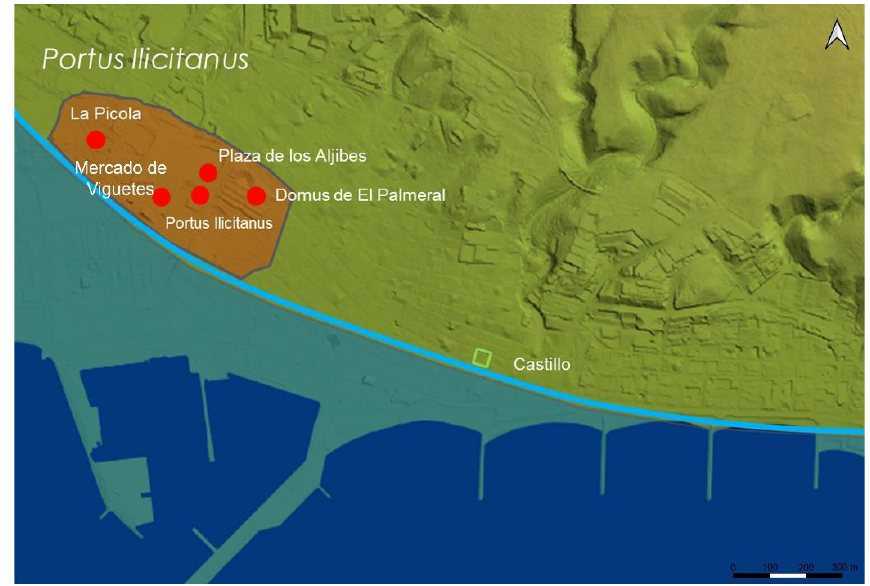
Figure 2. Location of the most significant sites of the Portus Ilicitanus and proposed coastline in Ro- man times (marked in